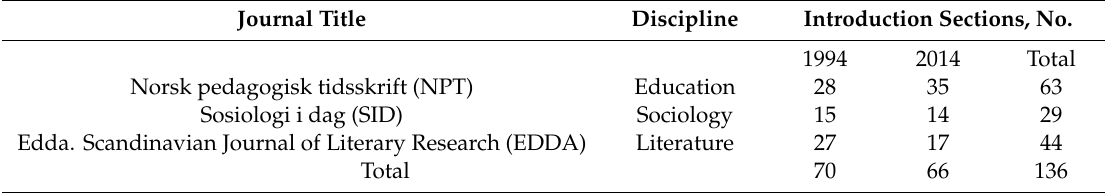
Table 1. Corpus by title of journal, discipline and number of introduction sections in each